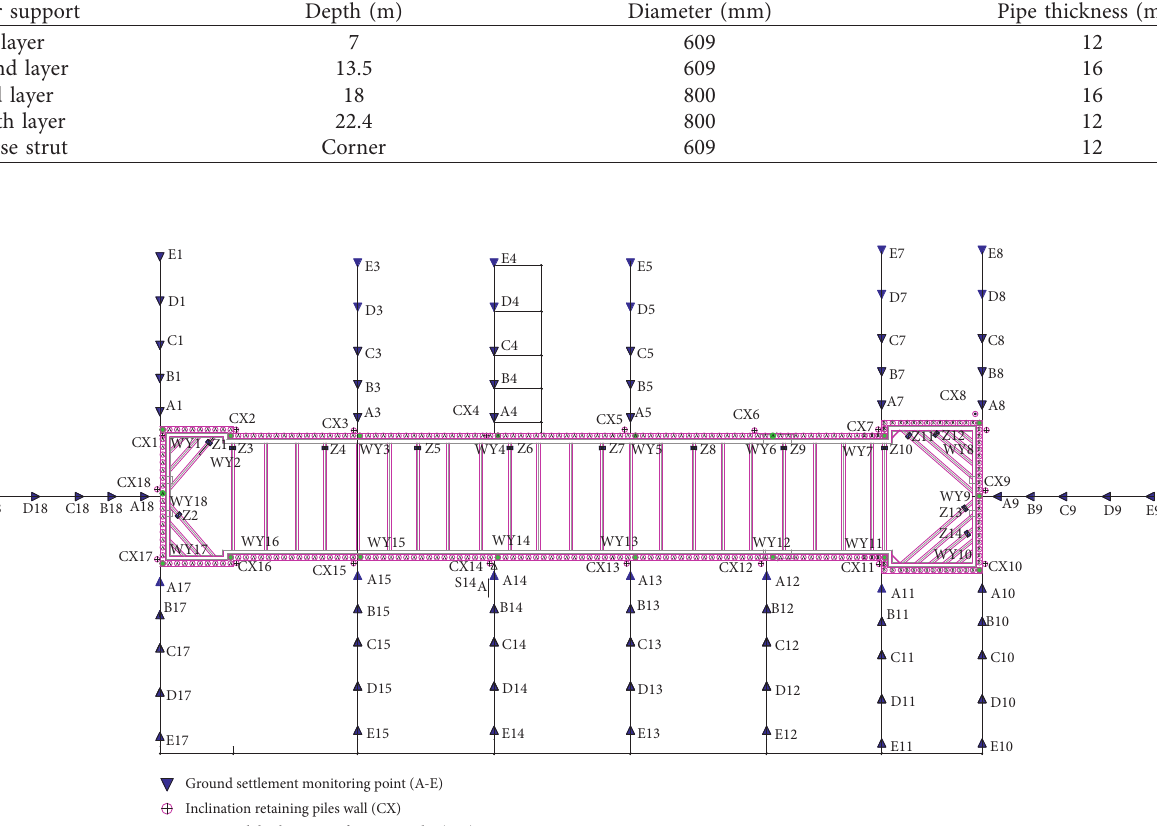
Figure 2: Layout of monitoring points around the deep excavation.